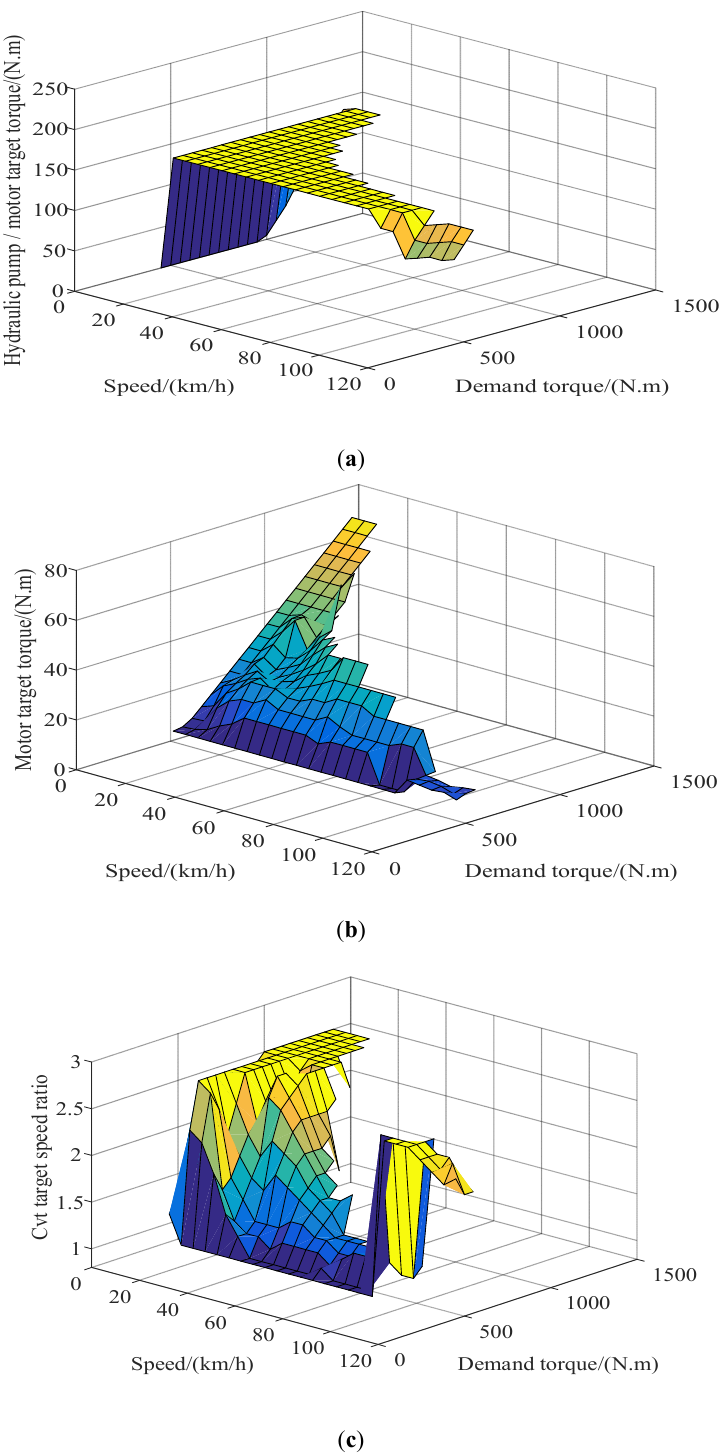
Figure 10. Optimization results in the electro-hydraulic hybrid drive mode: ( a ) hydraulic pump / motor target torque; ( b ) motor target torque; ( c ) target speed ratio of CVT.